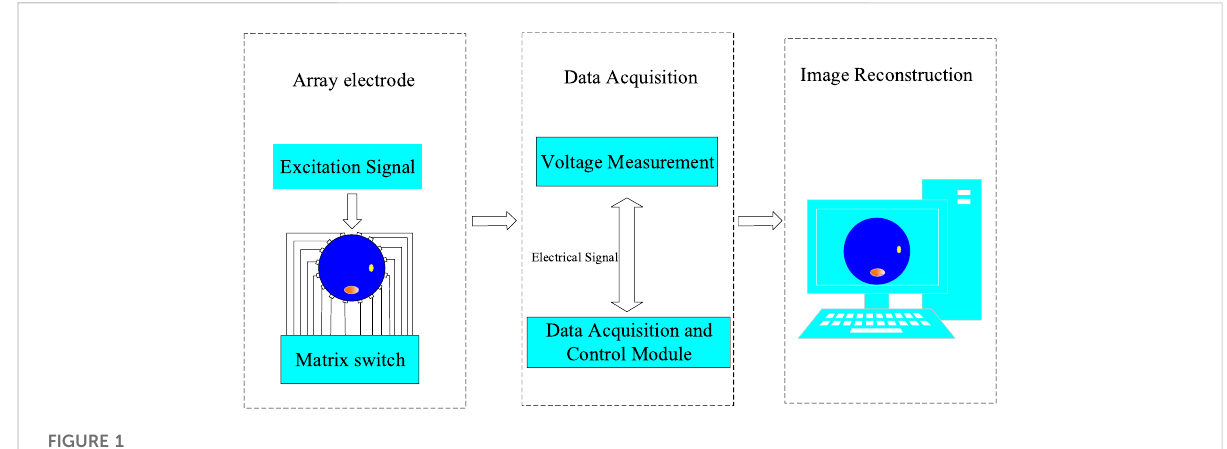
FIGURE 1 Block diagram of ERT